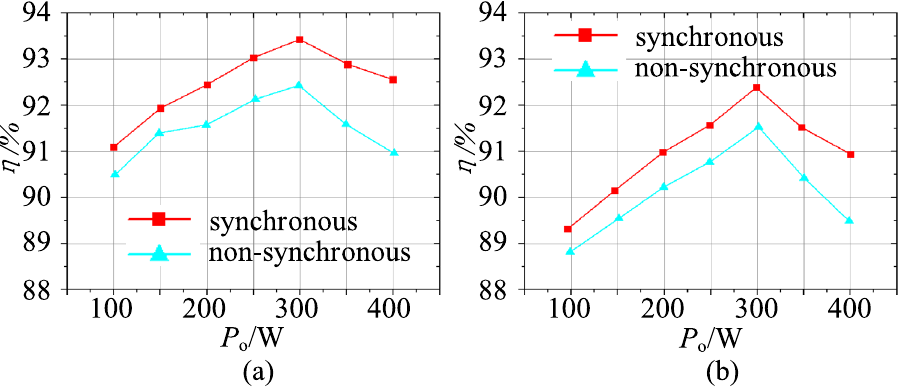
Figure 28. The efficiency curves with the load, ( a ) step-up mode, ( b ) step-down